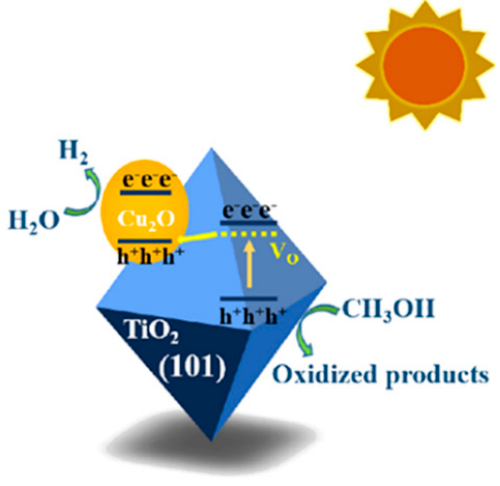
Figure 15. Schematic diagram of Z-schemed catalyst of Wei et al. [57] Reprinted with permission from ref. [57].